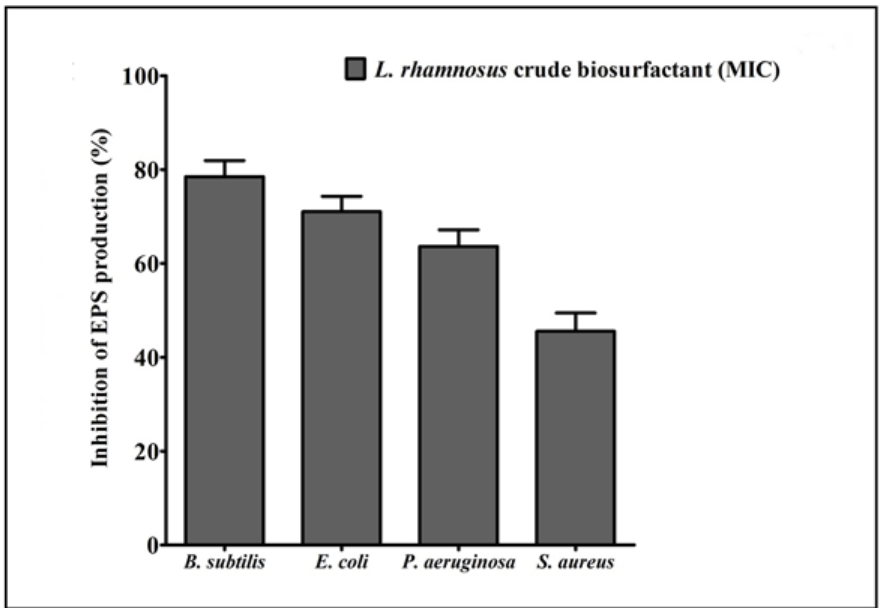
Figure 5. Inhibition of the total EPS production by the test pathogens in the presence of the L. rhamnosus crude biosurfactant at their respective MICs. Values are the mean ± SD of three independent experiments.